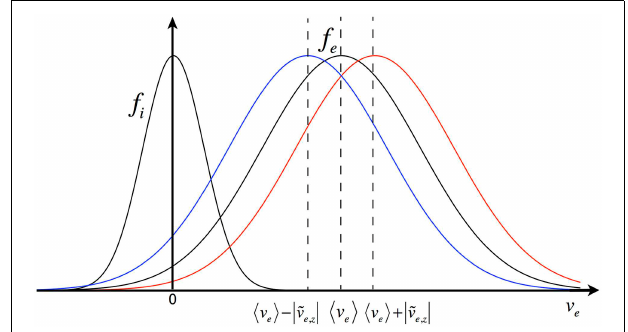
FIGURE 2 | Sketch of nonlinear shift of f e